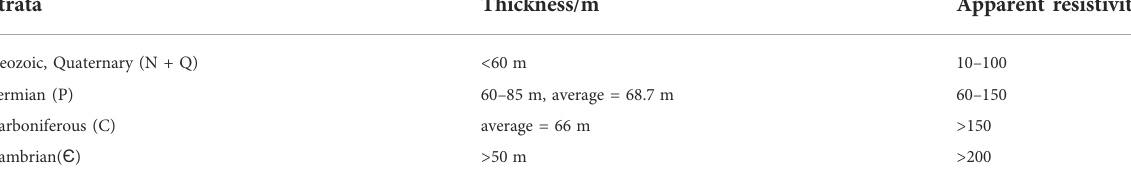
TABLE 1 Stratigraphic electrical properties in the underlying goaf of the substation.